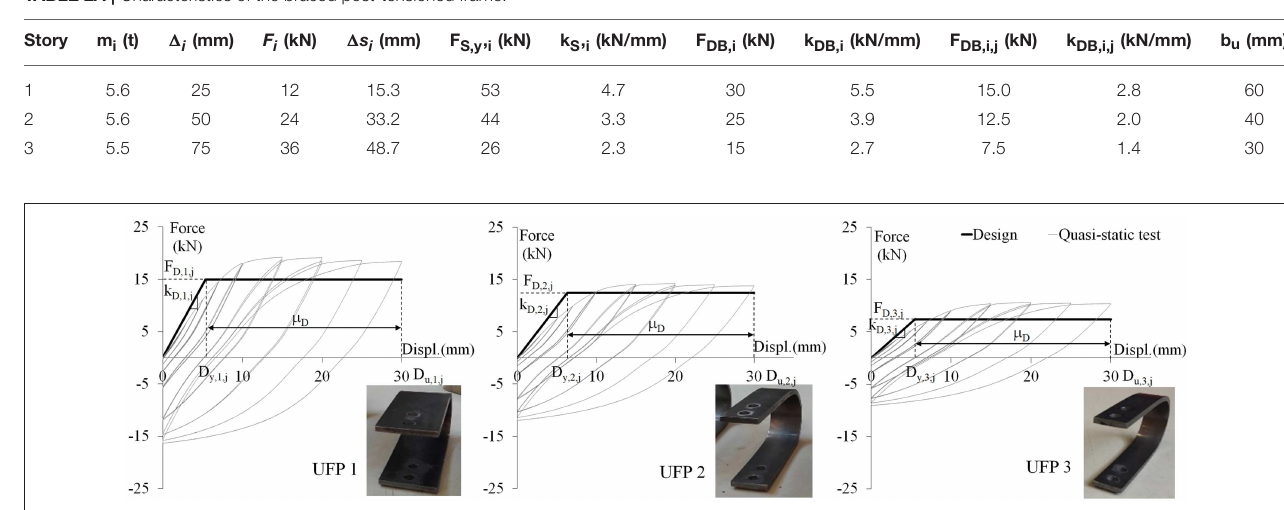
FIGURE 9 | Force-displacement of the UFP dampers at the three